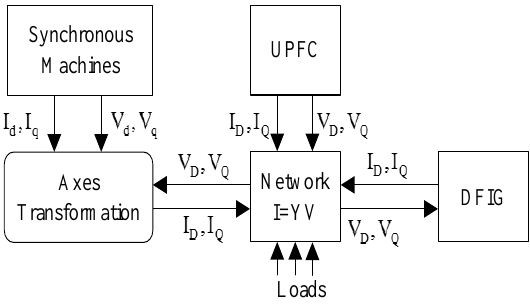
Figure 1. Block scheme of a power system with a UPFC and a DFIG.